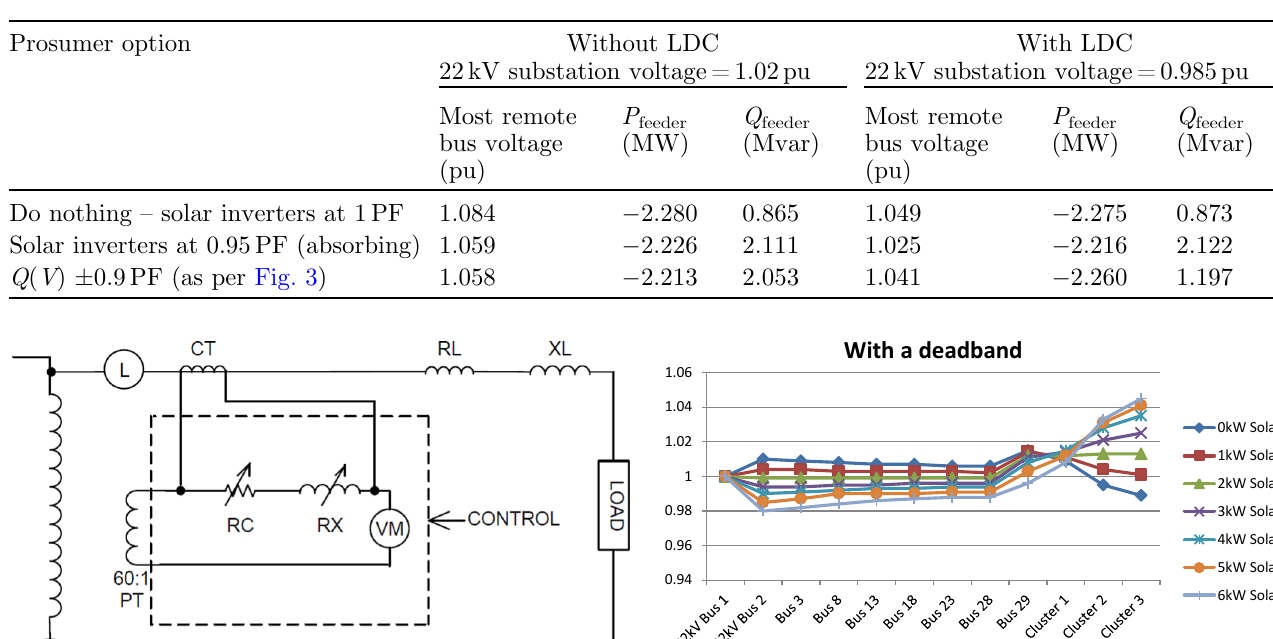
Table 3. Voltages at the most “ remote Bus ” for the selected prosumer options with 5 kW of solar power/house and 2 kVA at 0.85 PF household loads, without and with the utility LDC option. Note : the feeder ’ s P (reverse power fl ow) and Q demand are also shown for each combination.